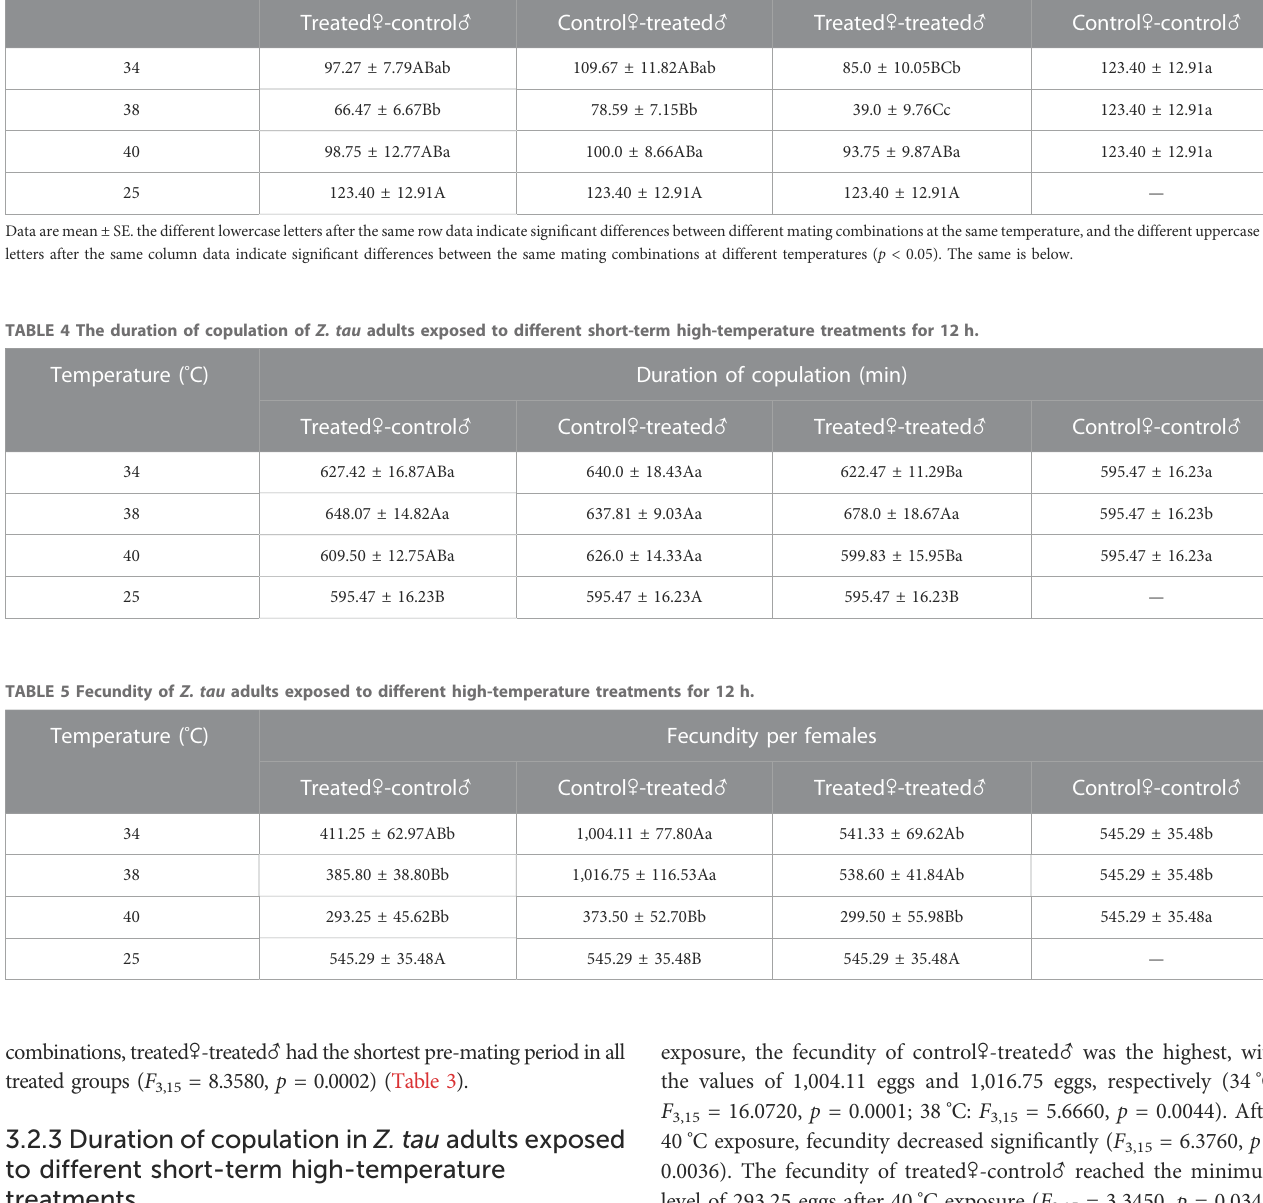
TABLE 3 The pre-mating period of Z. tau adults exposed to different high-temperature treatments for 12 h. Temperature ( ° C)